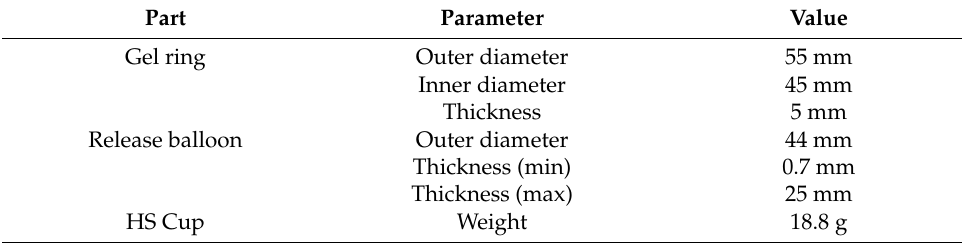
Figure 4. Developed prototype in two different modes: ( a ) side and bottom view of HS cup; ( b ) side and bottom view of the release balloon. Table 1. The Parameters of the developed HS cup.